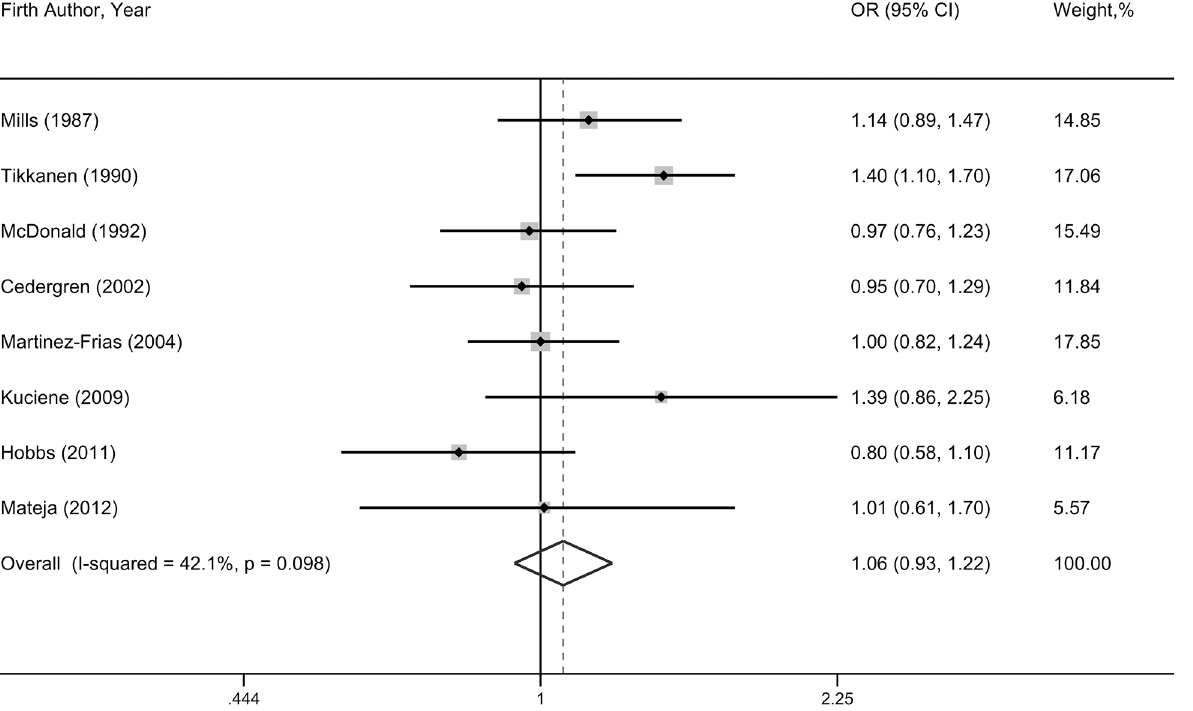
Fig 2. Forest plot of any prenatal alcohol exposure and overall congenital heart defects